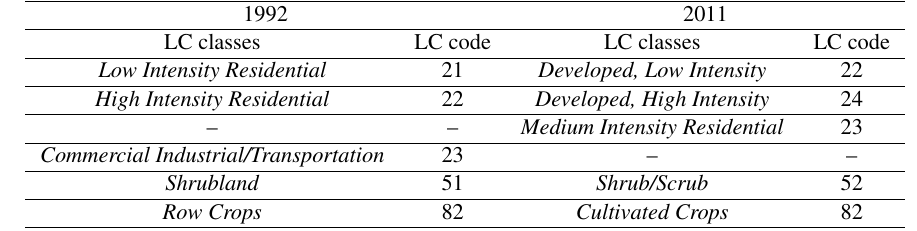
Table 1: NLCD codes variation over the years 1992-2011.